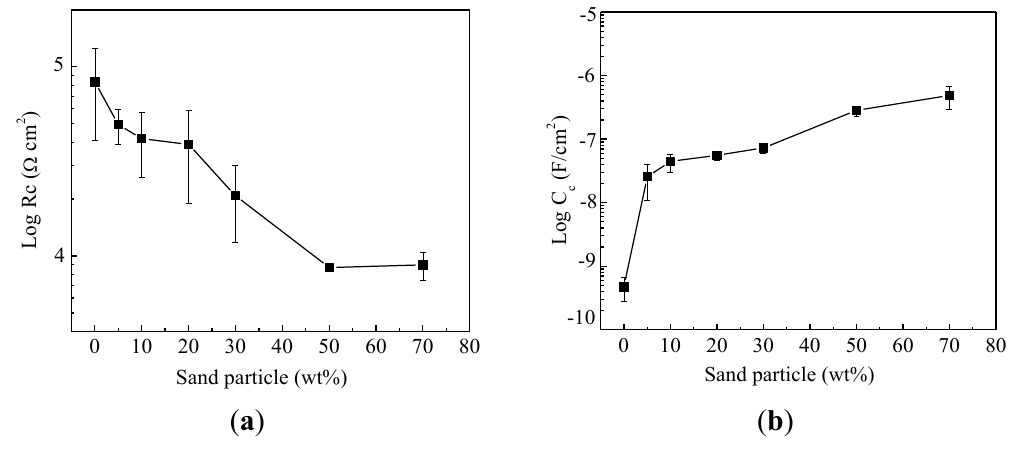
Figure 5. The effect of sand particle content on coating properties: ( a ) coating resistance; and ( b ) coating